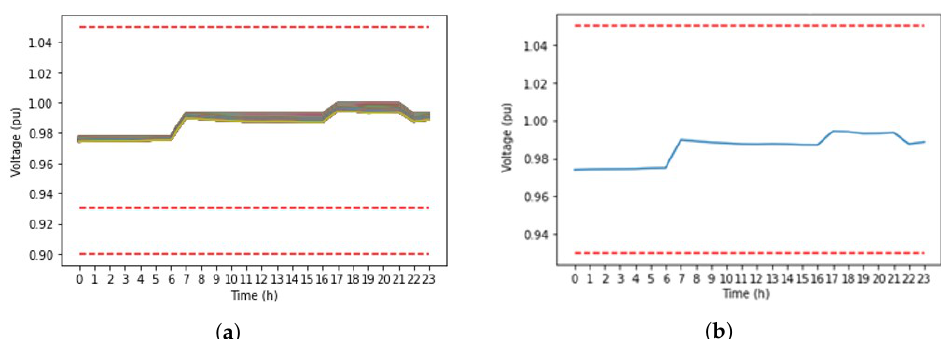
Figure 7. Voltage behavior and highlight for voltage on the Bus in which the microgrid is connected. ( a ) All buses from the feeder. ( b ) Bus with microgrid connection.